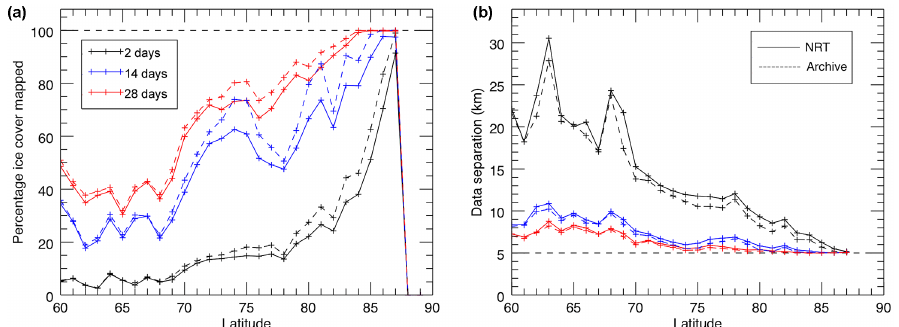
Figure 4. Spatial and temporal sampling of the Centre for Polar Observation and Modelling (CPOM) near-real-time (NRT) and archive Arctic sea-ice-thickness products, north of 60 ◦ N. (a) Percentage of sea ice cover mapped in 1 ◦ latitude bands, averaged over each month from October 2014 to April 2015. Data are plotted for the final 28, 14 and 2 days of all months. Solid lines show NRT data, dashed lines show archive data. (b) Mean separation between measurement points in 1 ◦ latitude bands, averaged over each month from October 2014–April 2015. Data are plotted for the final 28, 14 and 2 days of all months. Solid lines show NRT data, dashed lines show archive data.